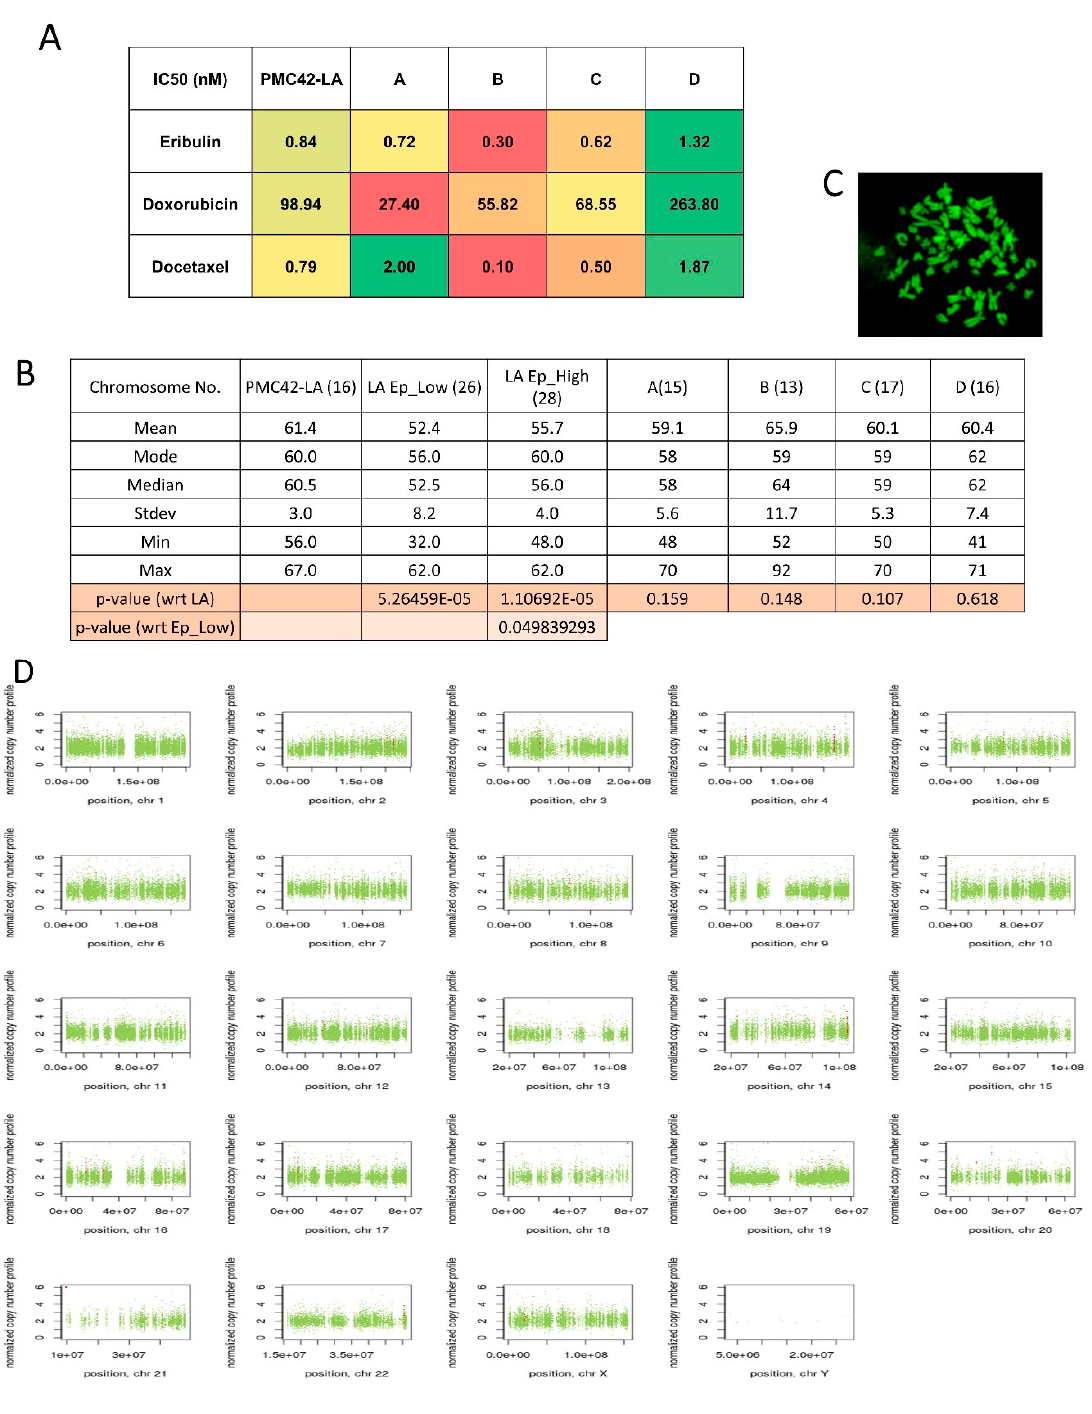
Figure 8. ( A ) Plot of heatmap on the basis of computed IC50 values of the drugs eribulin, doxorubicin, and docetaxel for PMC42-LA and the four selected clones. ( B ) Measurements of central tendency from distribution of chromosome number across PMC42 LA, EpCAM sorted subpopulations and four clones. Student t -test was applied to calculate p -value. ( C ) Metaphase spreads of PMC42-LA chromosomes stained with DAPI and imaged with confocal microscopy. ( D ) Visualization of Control-FREEC v6.0 output from PMC42-LA sorted EpCAM subpopulations whole exome sequencing data (Illumina HiSeq 2000). Copy number profiles for all chromosomes are shown for EpCAM low subpopulation in comparison to EpCAM high ; normal copy number status is shown in green, copy number gains are represented in red, and copy number losses are represented in blue.